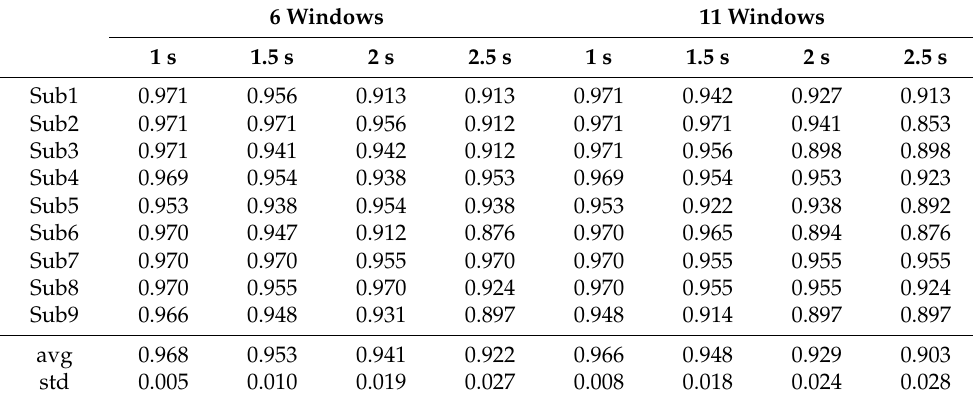
Table 2. The validation accuracy for AS algorithm.